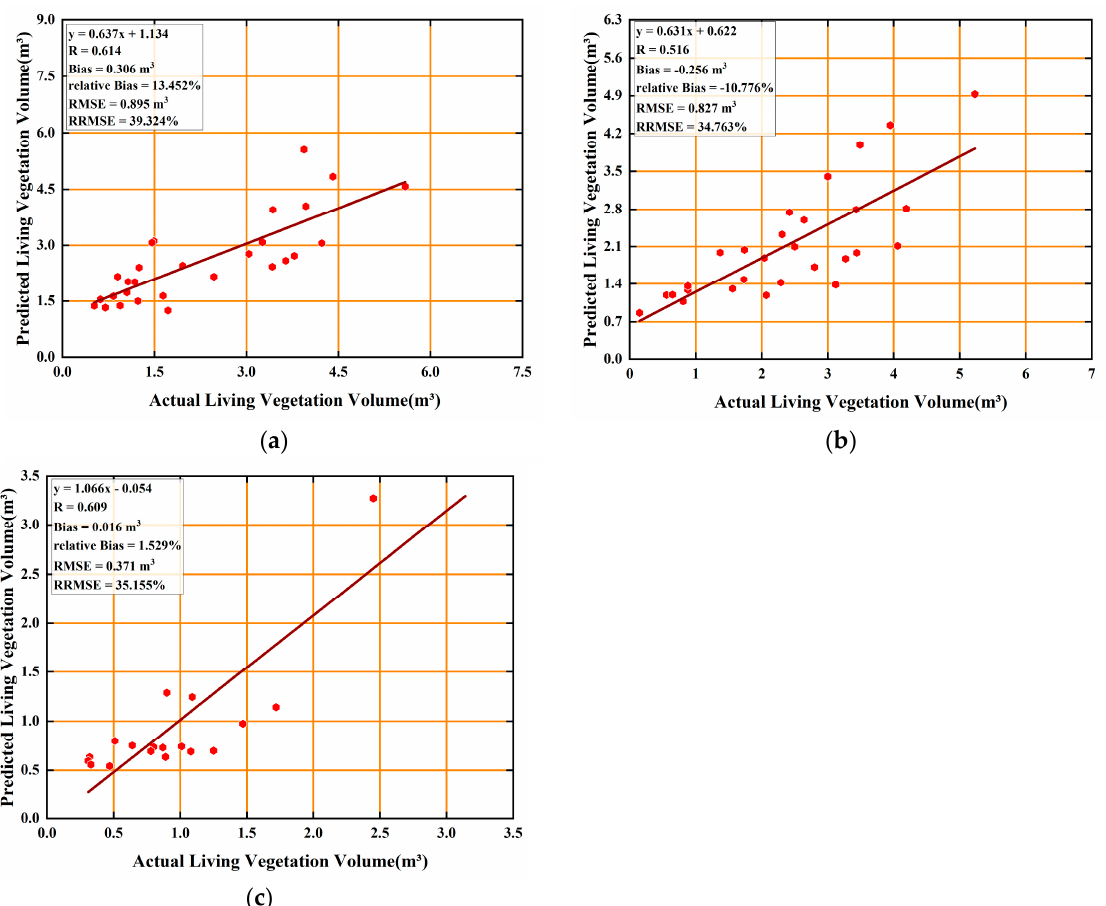
Figure 11. Accuracy evaluation of LVV and yellow leaf disease of arecanut severity model: ( a ) evaluation results of model accuracy in areca area A; ( b ) evaluation results of model accuracy in areca area B; ( c ) evaluation results of model accuracy in areca area C.